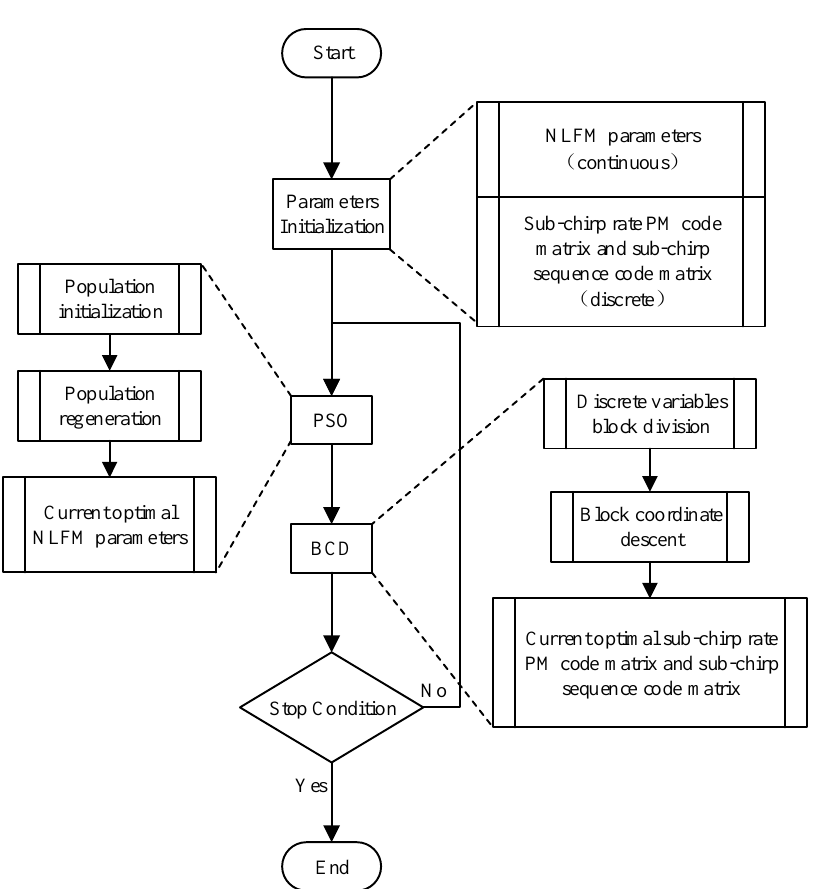
Figure 3. Block diagram of proposed OFDM-NLFM waveform set design